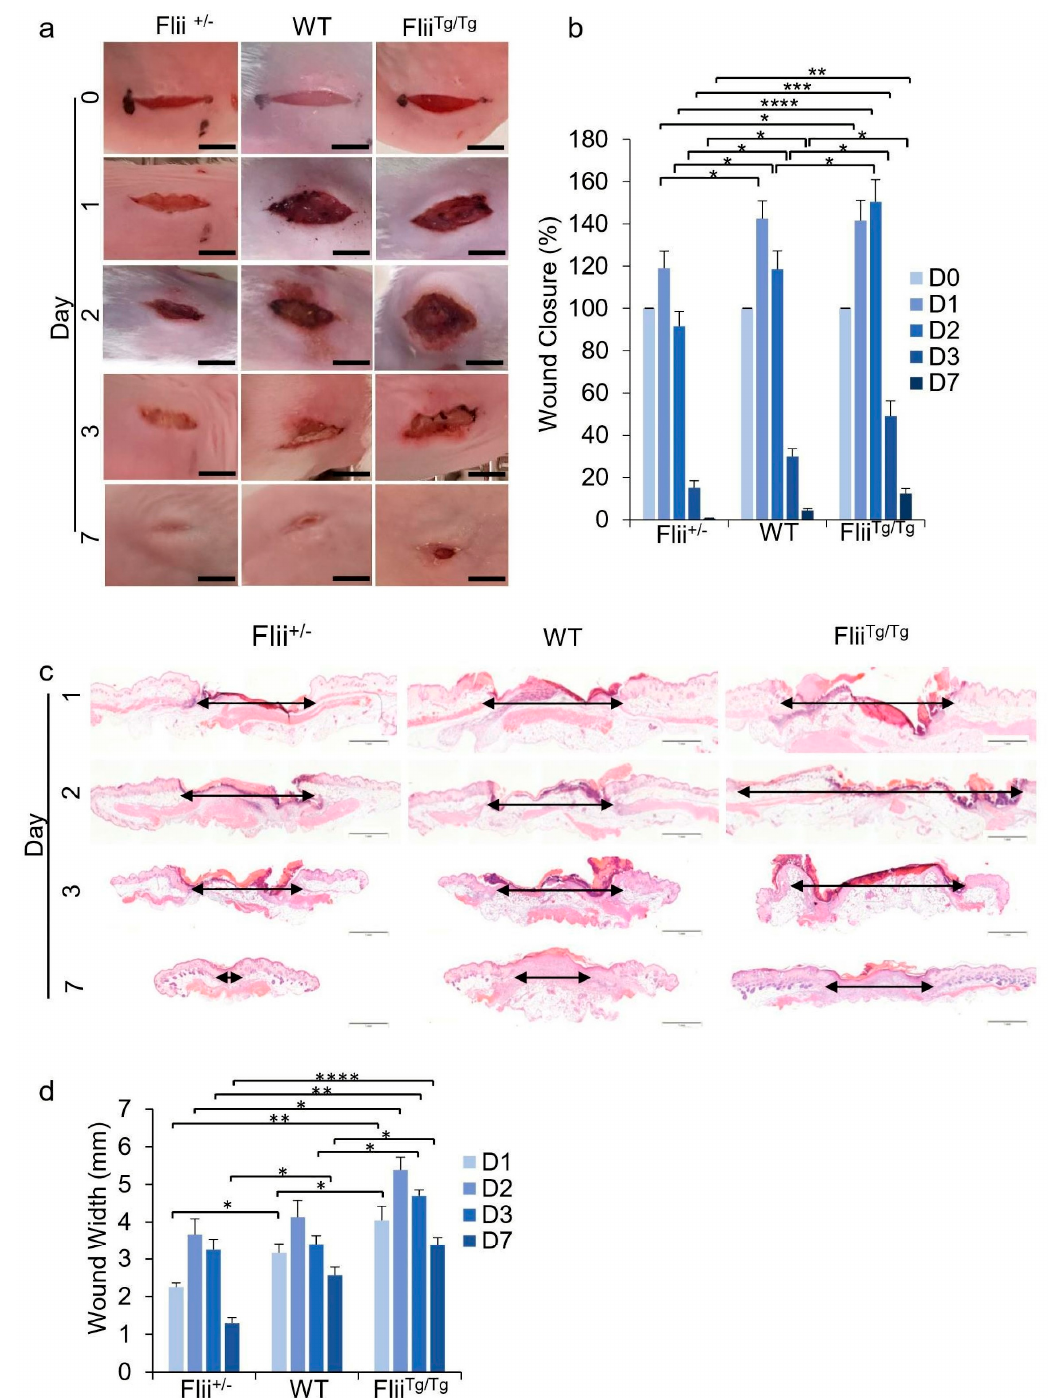
Figure 5. Wound closure in 3 Flii genotypes (Flii +/ − , WT and Flii Tg/Tg ): ( a ) Representative incisional murine wound photographs from the 3 genotypes over a 7-day timecourse; ( b ) Bar graph showing percentage wound closure ( n = 6); ( c ) Representative images of H&E staining of the murine incisional wounds; ( d ) Bar graph showing wound width measurements ( n = 6). Scale bars = 0.5 mm for ( a ), and scale bars = 1 mm for ( c ). Results are expressed as mean ± SEM. * p < 0.05, ** p < 0.01, *** p < 0.001, and **** p <